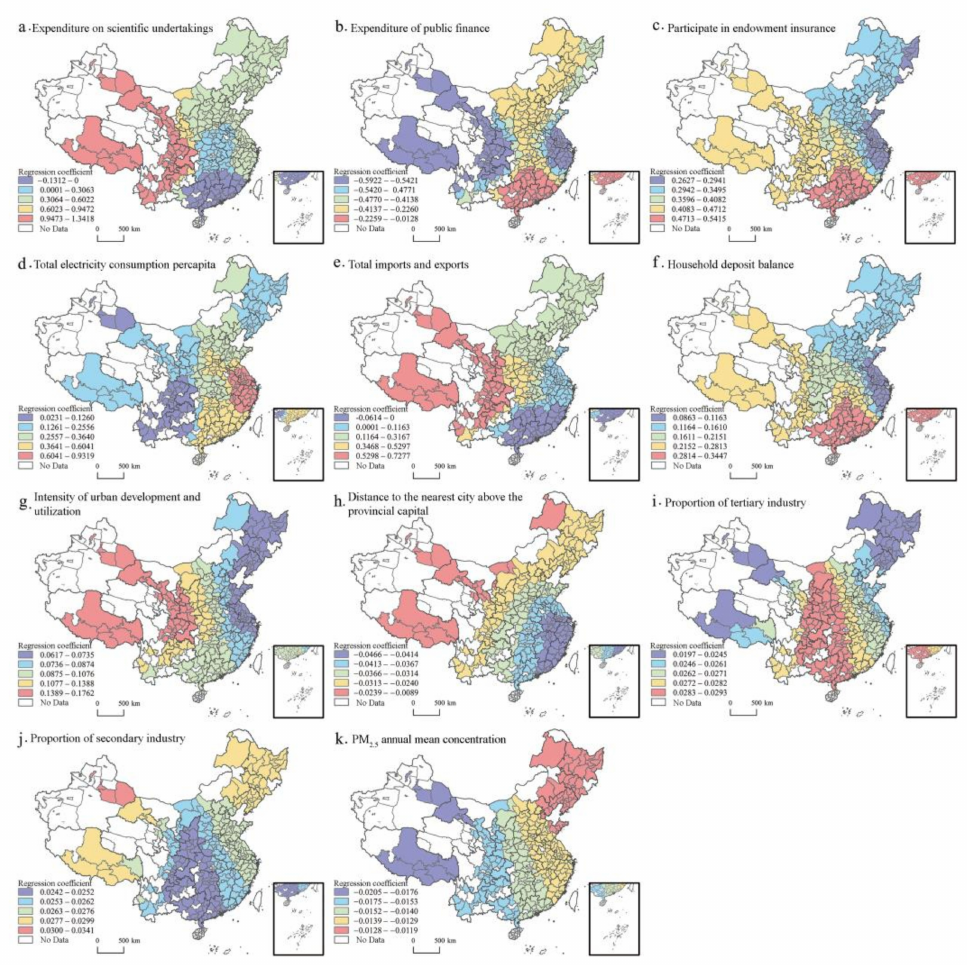
Figure 8. Spatial distribution of regression coefficients in the